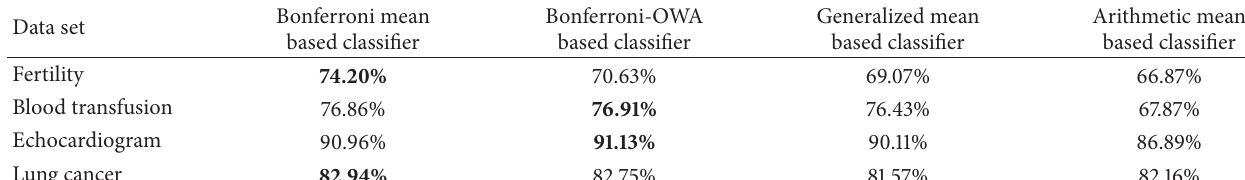
Table 9: A summary of classification accuracies for each of the similarity classifiers.